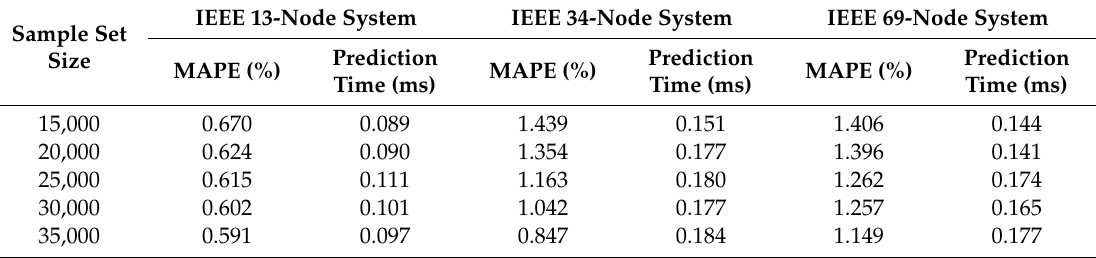
Table 5. Comparison of prediction results for di ff erent distribution